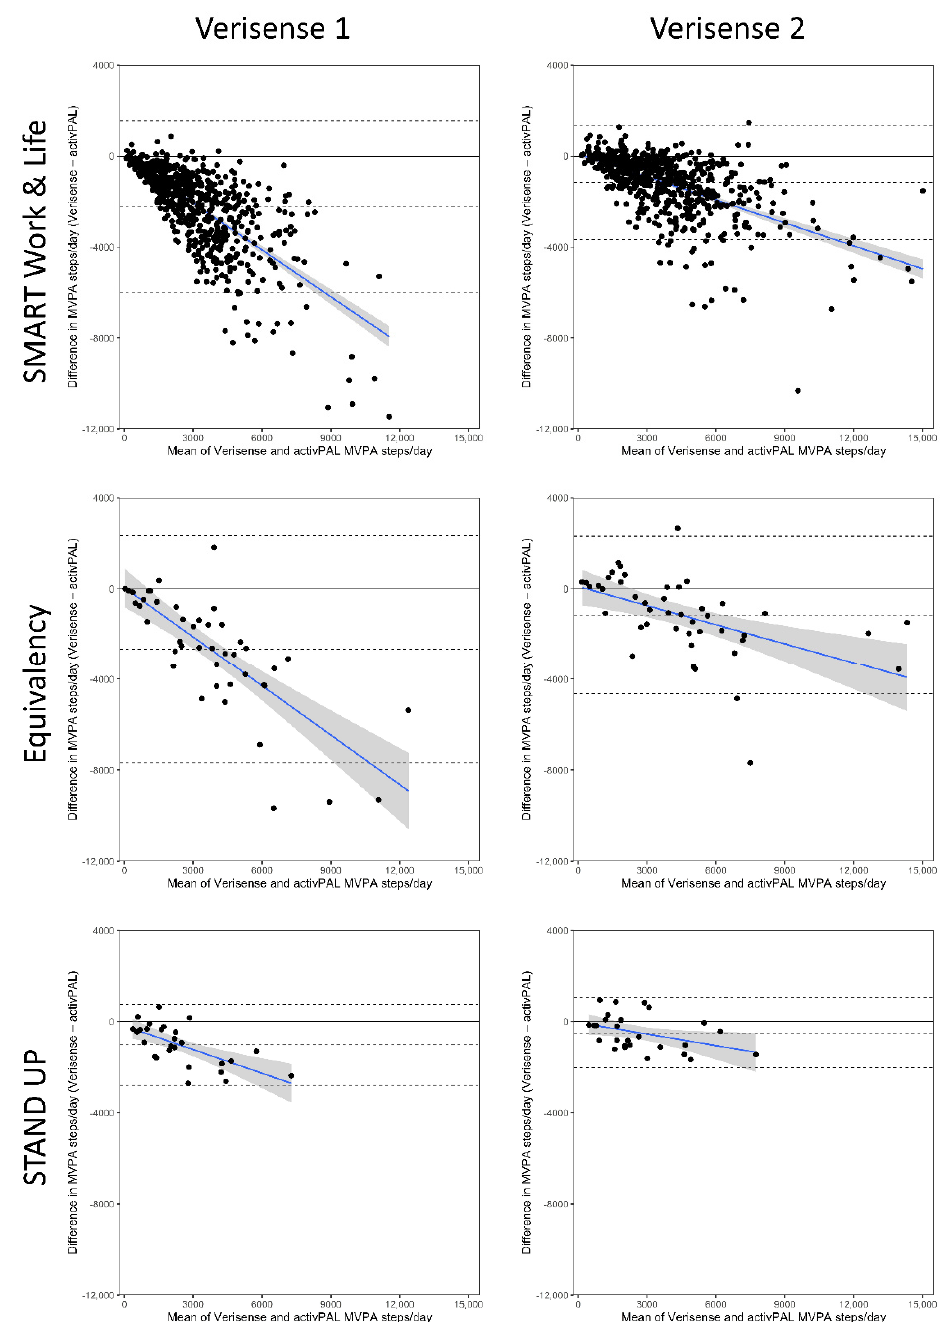
Figure 4. Bland–Altman Plots of MVPA steps/day derived from the Verisense algorithm compared with the activPAL split by study and algorithm version. The blue line depicts mean (95% CI) proportional bias. Dashed black lines depict ± 95% limits of agreement and mean bias. LoA, Limits of Agreement. Table 4. Agreement between MVPA steps derived by the activPAL and MVPA steps derived by the Verisense algorithms applied to wrist accelerometer data.